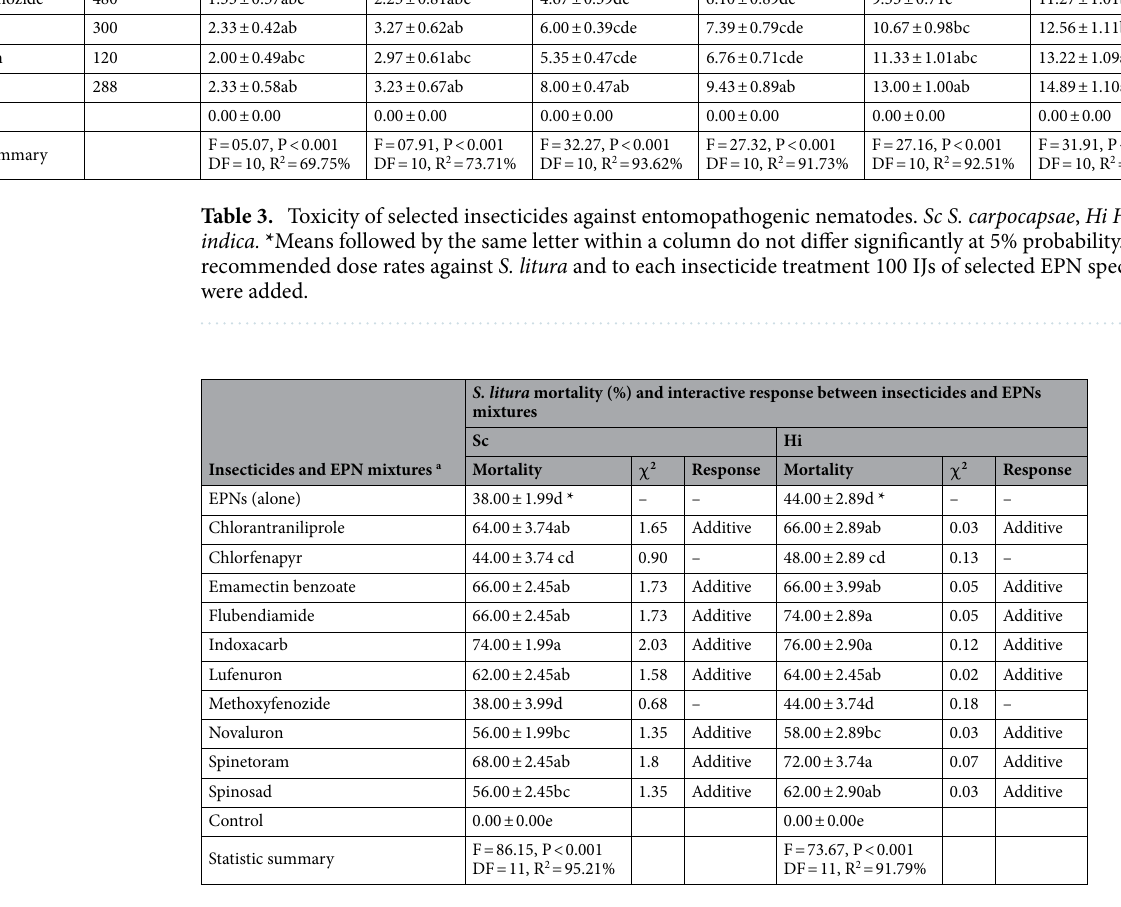
Table 4. Toxicity of selected insecticides and nematode mixtures against S. litura after 72 h of treatment applications. Sc S. carpocapsae , Hi H. indica. * Means followed by the same letter within a column do not differ significantly at 5% probability. a Median lethal concentrations (LC 50 ) of insecticides and 500 IJs of each EPN specie were applied in each treatment